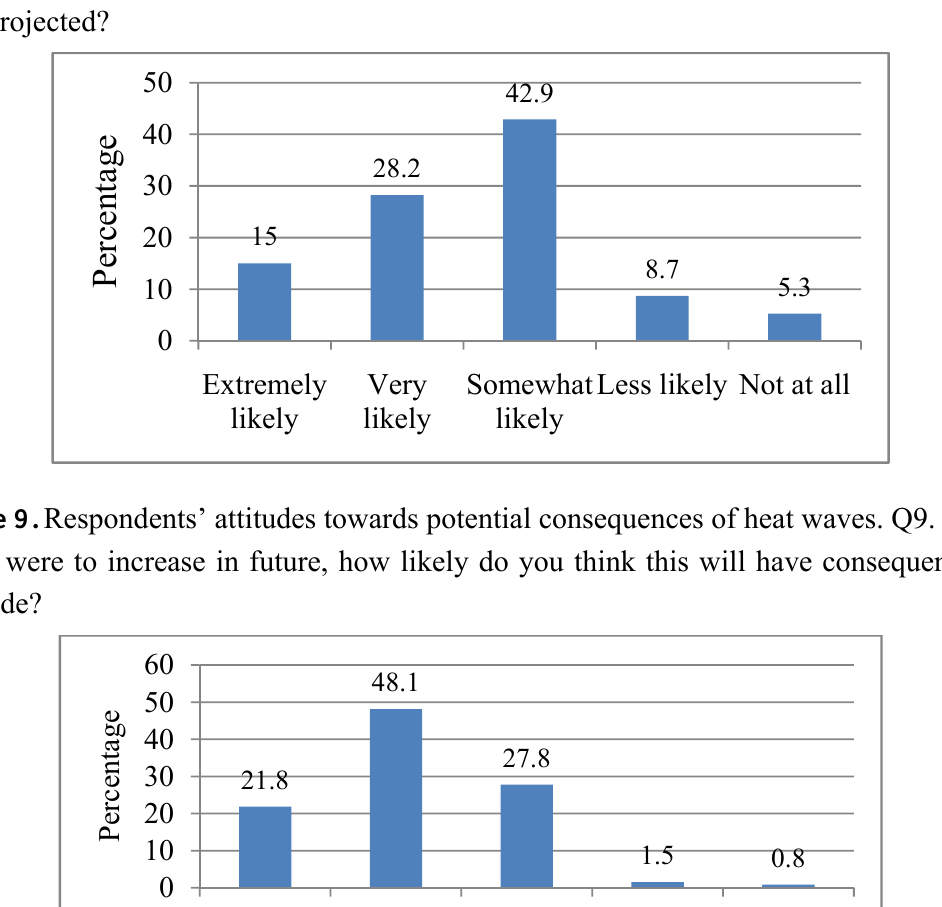
Figure 8. Respondents’ attitudes towards scientific projections about heat waves. Q8. How